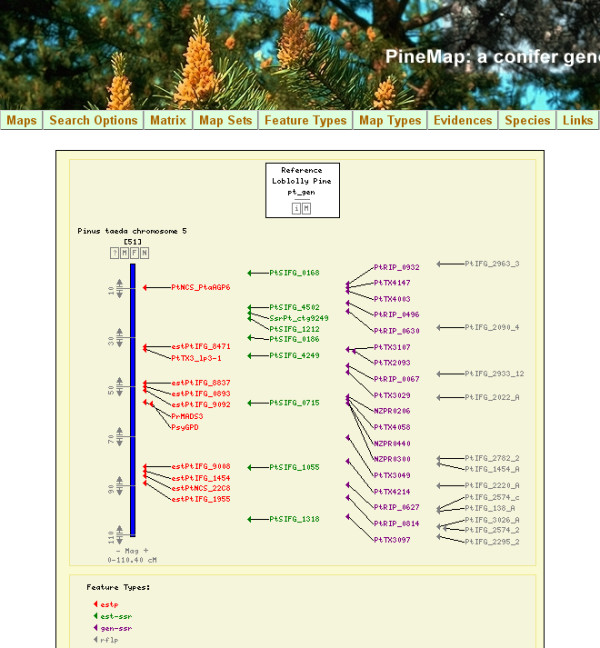
PineMap user interface. A web page screen capture of the CMap graphic display for LG-5 of the Map Set Pinus_Taeda_Base_&_QTL_SSR_Version_1 in PineMap [34]. Markers are colour-coded according to marker type. Each marker is hyperlinked to its mapping, annotation, and DNA sequence data. Map, annotation, and sequence data for all markers, and for map metadata, can be downloaded from links available through the Map Sets tab found on the top menu bar